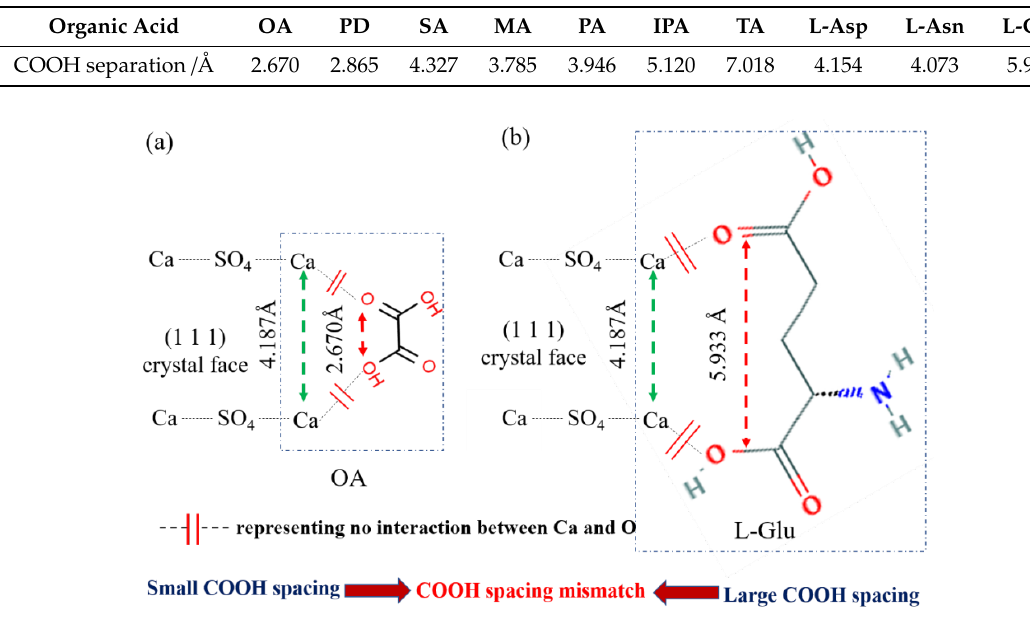
Figure 14. Schematic diagram of OA ( a ) and L-Glu ( b ) on the (111) surface of CaSO 4 ·0.5H 2 O.